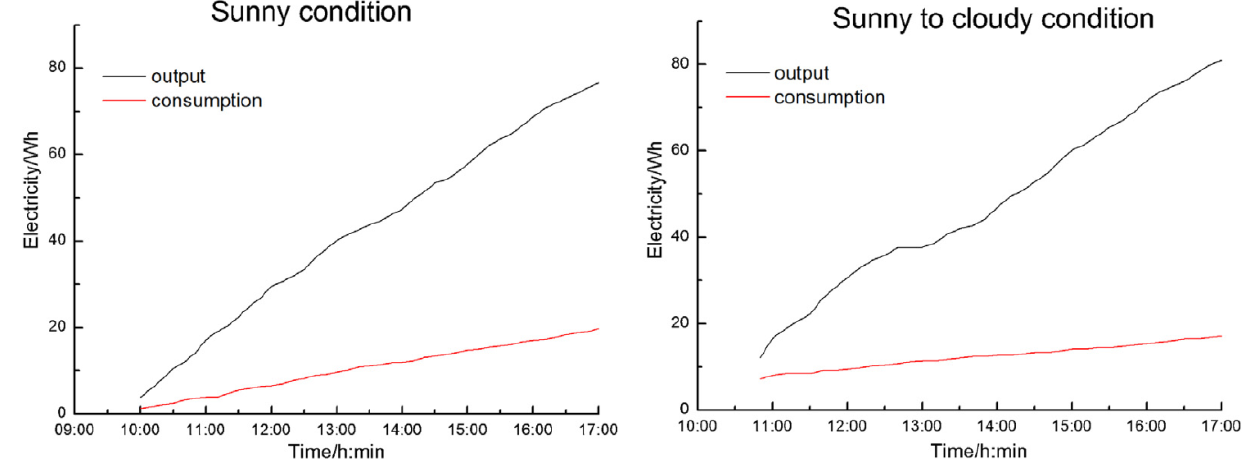
Figure 20. Effect of weather on the energy output and consumption of an air cushion combined with PV panels [118].